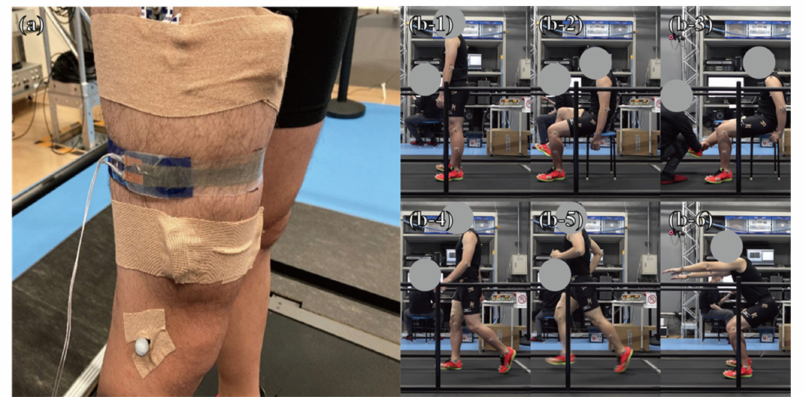
Figure 2. ( a ) Attachment of the DATSURYOKU sensor. ( b-1 ) Standing position, ( b-2 ) sitting position, ( b-3 ) passive extension and flexion of knee joint, ( b-4 ) walking, ( b-5 ) running, and ( b-6 )